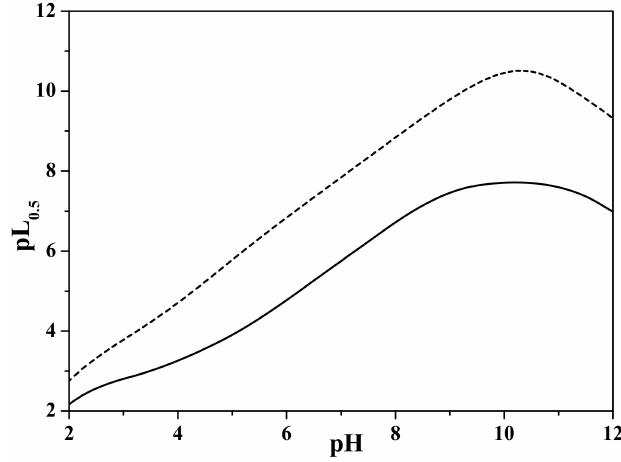
Figure 3. Dependence of the pL 0.5 in pH at I = 0.05 mol kg − 1 (dotted line) and I = 0.72 (solid line) mol kg − 1 at T = 298.15 K and p = 0.1